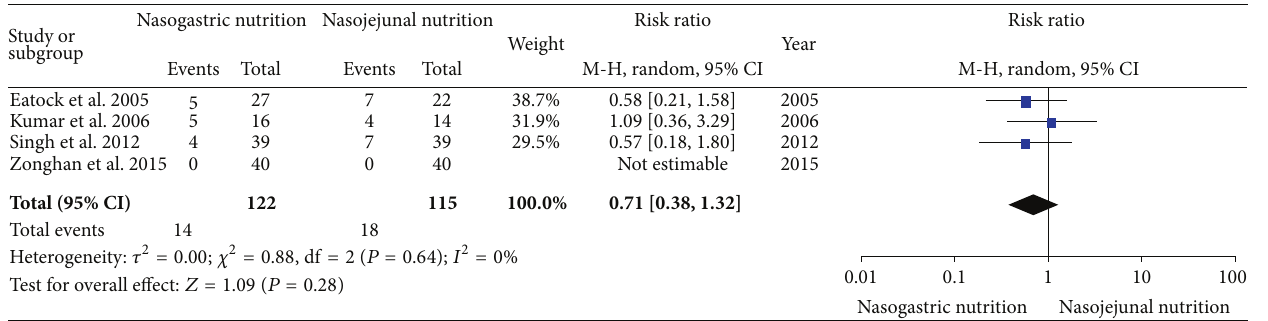
Figure 3: Comparison of mortality between the NG and NJ nutrition